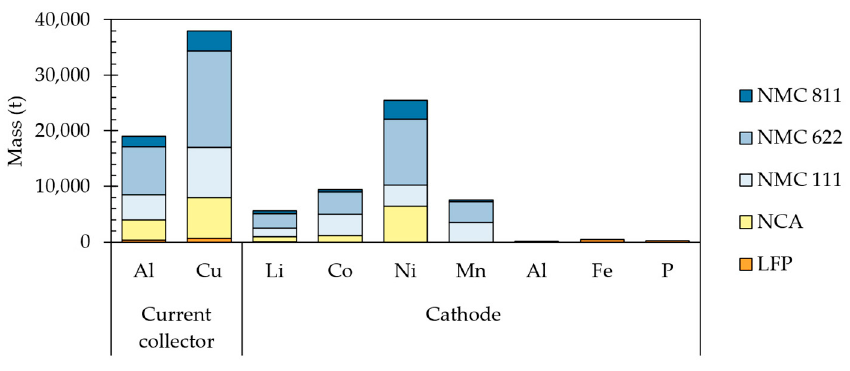
Figure 3. Amounts of potentially recoverable metals (t) entailed in LIBs’ cathodes and current collectors associated to European EVs’ fleet in 2020.